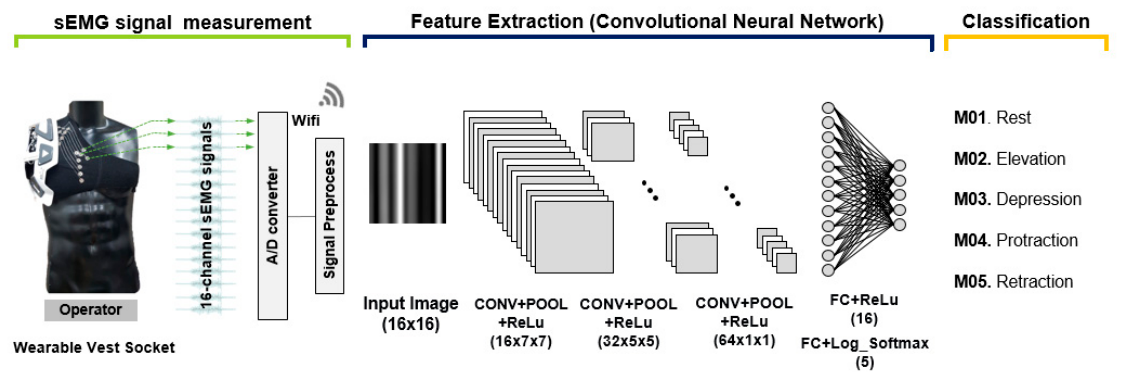
Figure 7. Overview of the proposed shoulder posture classification process.